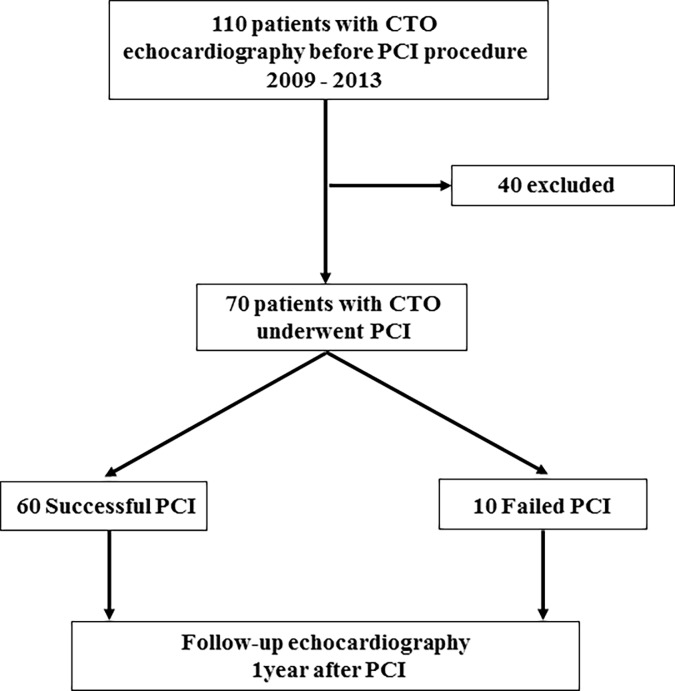
Patient flow chart.